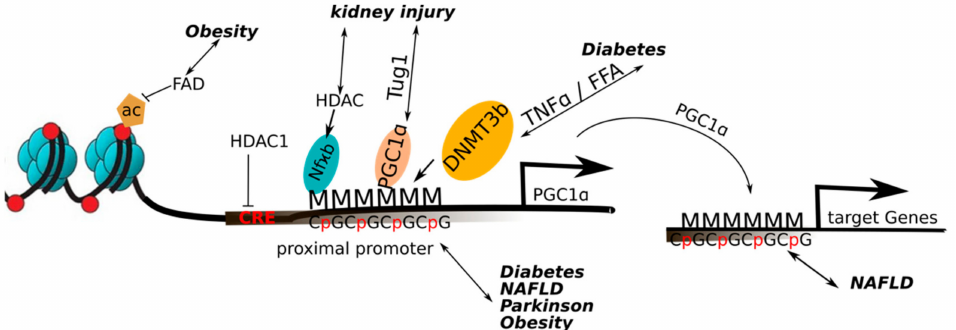
Figure 3. Overview of the epigenetic changes on the PGC-1 α in a pathological context: Increased methylation of the PGC-1 α promoter has been found to occur in obesity, diabetes, non-alcoholic fatty liver disease (NAFLD) and Parkinson’s disease. Obesity and decreased flavin adenine dinucleotide (FAD) levels lead to a loss of histone 3 acetylation and thus a decreased gene expression of PGC-1 α . Exposure to TNF α or FFA (free fatty acids) leads to a hypermethylation of the PGC-1 α promoter by the activation of DNA methyltransferase 3b (DNMT3b). In NAFLD, a decreased expression of PGC1 α target genes was associated with higher methylation of the respective promoters. In kidney diseases, the micro RNA taurine upregulated gene (TUG1) promotes the binding of PGC-1 α to its own promoter. In acute kidney injury, histone deacetylase (HDAC) recruitment to nuclear factor κ B (NF- κ B) on the PGC-1 α promoter promotes deacetylation and thus repression of PGC1 α . Increased